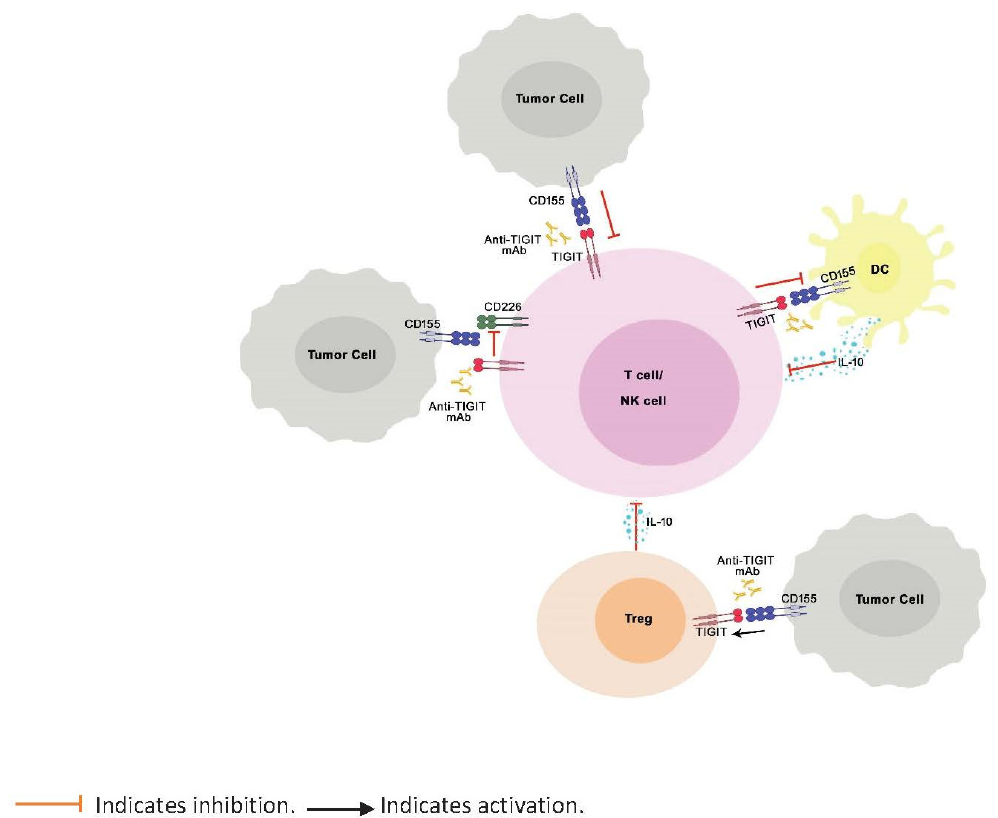
Figure 1. Role of TIGIT in regulation of immune response. TIGIT competitively inhibits binding of CD226 to CD155 and impairs the CD226-mediated activation of T cells and NK cells. Binding of TIGIT to its ligand CD155 results in activation of inhibitory signals in T cells and NK cells. TIGIT binding to CD155 on APCs results in IL ‐ 10 production, decreased IL ‐ 12 production (not shown in the illustration), and indirect inhibition of T cells. Finally, TIGIT signaling enhances the immunosuppressive functions of Tregs.